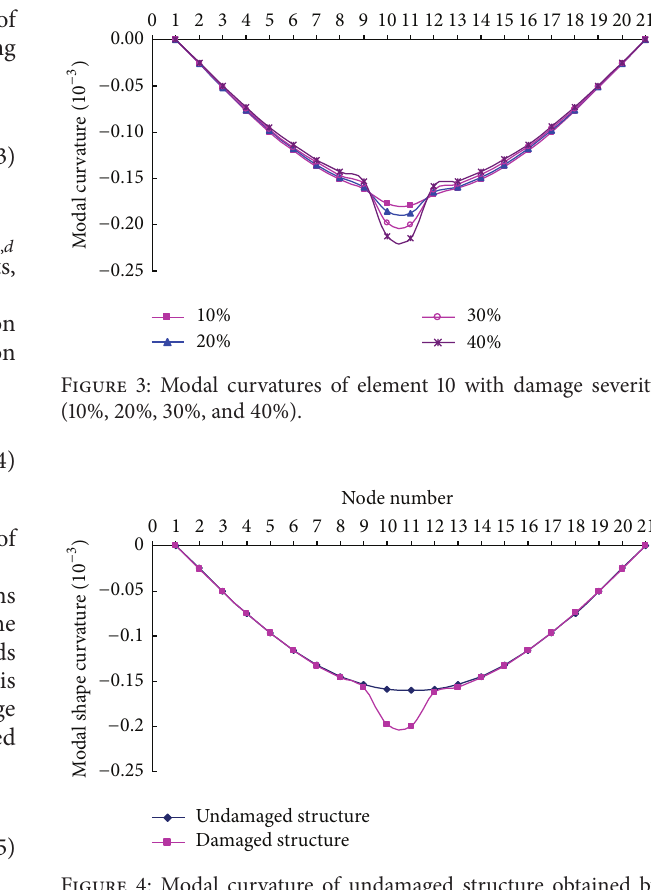
Figure 4: Modal curvature of undamaged structure obtained by Chebyshev polynomial fitting for damage identification with single